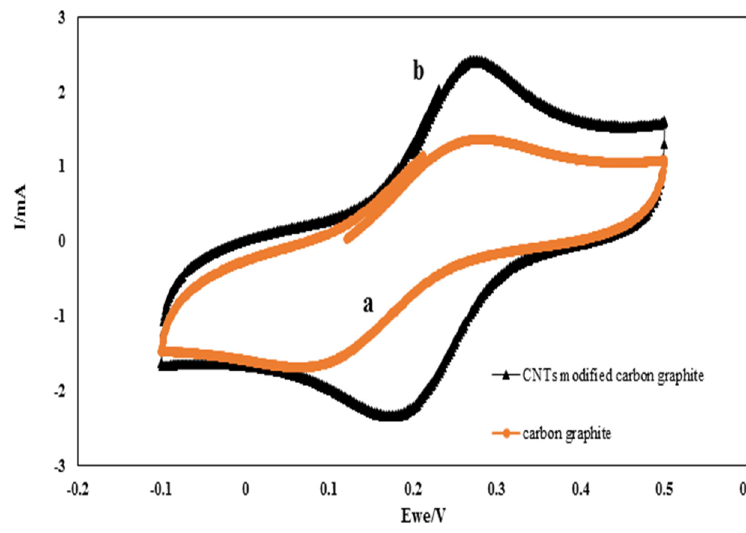
Figure 2. CV of the cathode ( a ) before and ( b ) after modification with